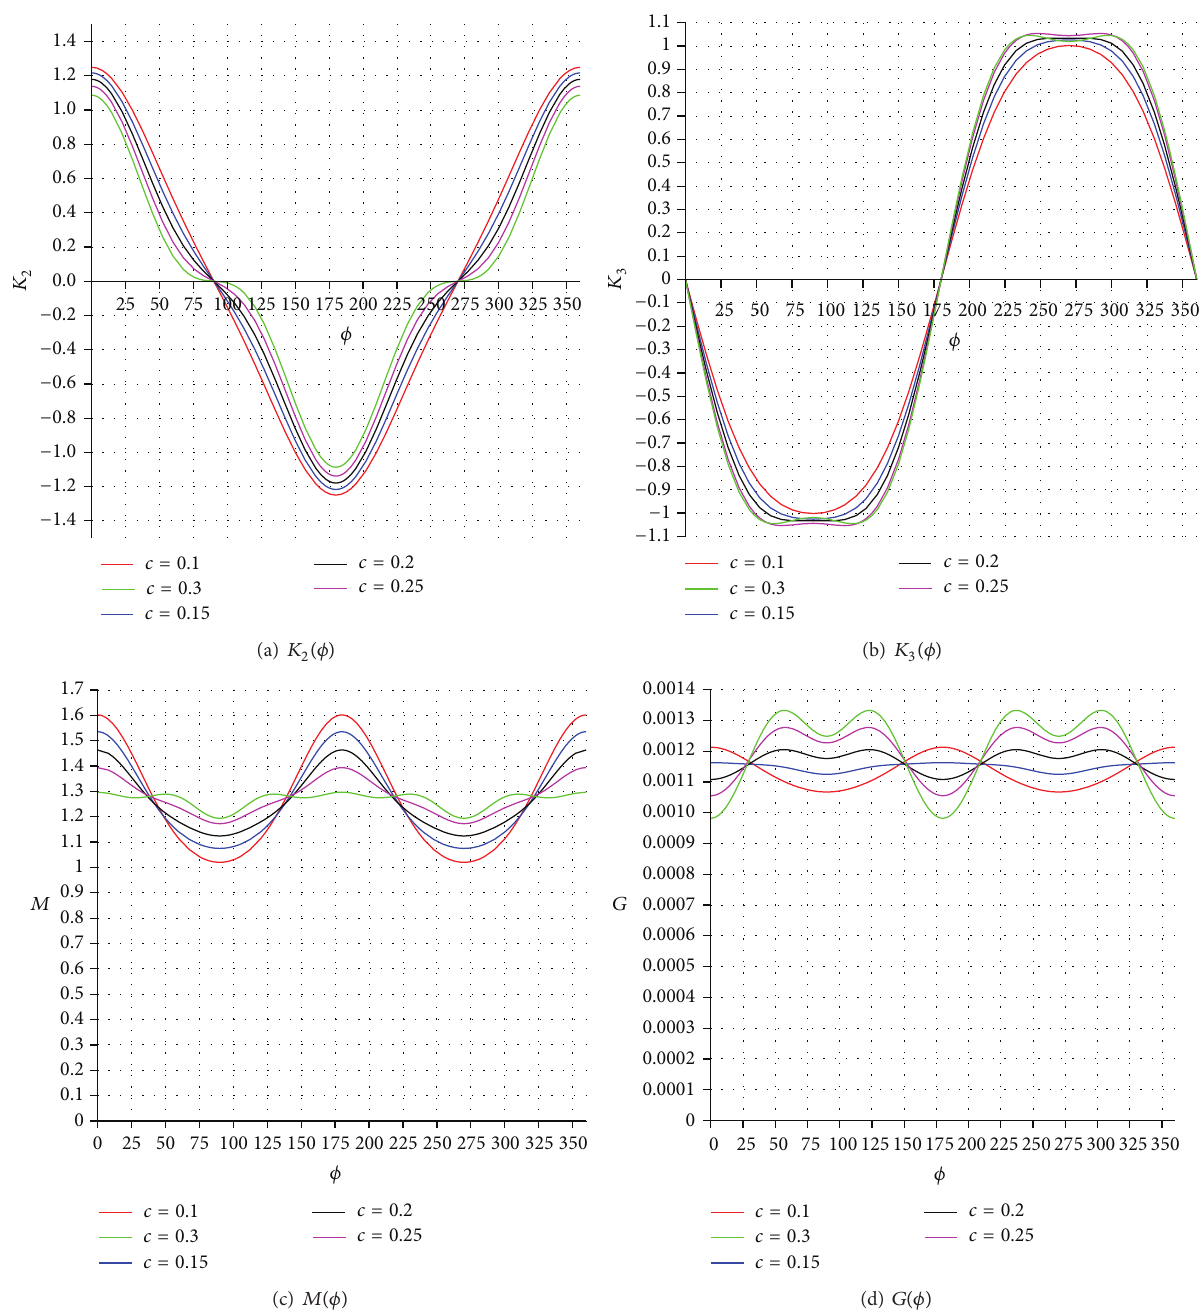
Figure 8: The 𝐾 2 (𝜙) , 𝐾 3 (𝜙) , 𝑀(𝜙) , and 𝐺(𝜙) for 𝑓(𝜁) = 𝜁 + 𝑐𝜁 3 at various 𝑐